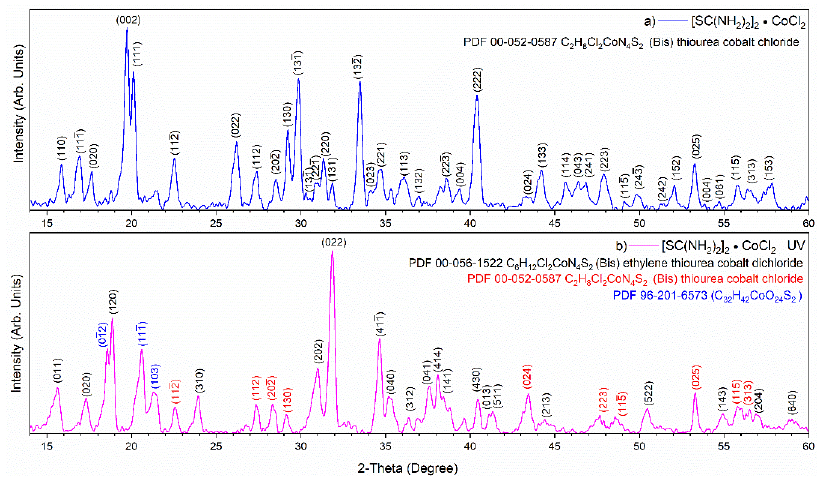
Figure 9. XRD pattern: ( a ) crystals without UV assistance; ( b ) crystals with UV assisted. In section (b), with UV assistance, different crystalline phases are shown; first, black color numbered planes coincide with the powder diffraction pattern (PDF 00-056-1522), which corresponds to (bis) ethylene thiourea cobalt dichloride [11]. The red color numbered planes coincide with (PDF 00-052-0587), which corresponds to the (bis) thiourea cobalt chloride showed in section (a). The (012), (111) and (103) blue planes, match the powder diffraction pattern (PDF 96-201-6573, C 32 H 42 CoO 24 S 2 ) [12], another thiourea complex. Both diffraction patterns retain some similarities to each other when comparing the intensities of the planes in red color for (bis) thiourea cobalt chloride, but other complexes are also obtained (planes in black and blue). The pattern obtained from the crystals without ultraviolet assistance shows a monoclinic structure called (bis) thiourea cobalt chloride in its entirety. In contrast, the diffraction pattern obtained from the crystals with ultraviolet assistance has a polycrystalline composition. The structure called (bis) ethylene thiourea used (ethanol) in its crystalline structure, in addition to forming other complexes, such as C 32 H 42 CoO 24 S 2 and partly (bis) thiourea cobalt chloride. Although the UV-assisted crystal structure has a more defined crystalline geometry, other cobalt–thiourea complex forms are also